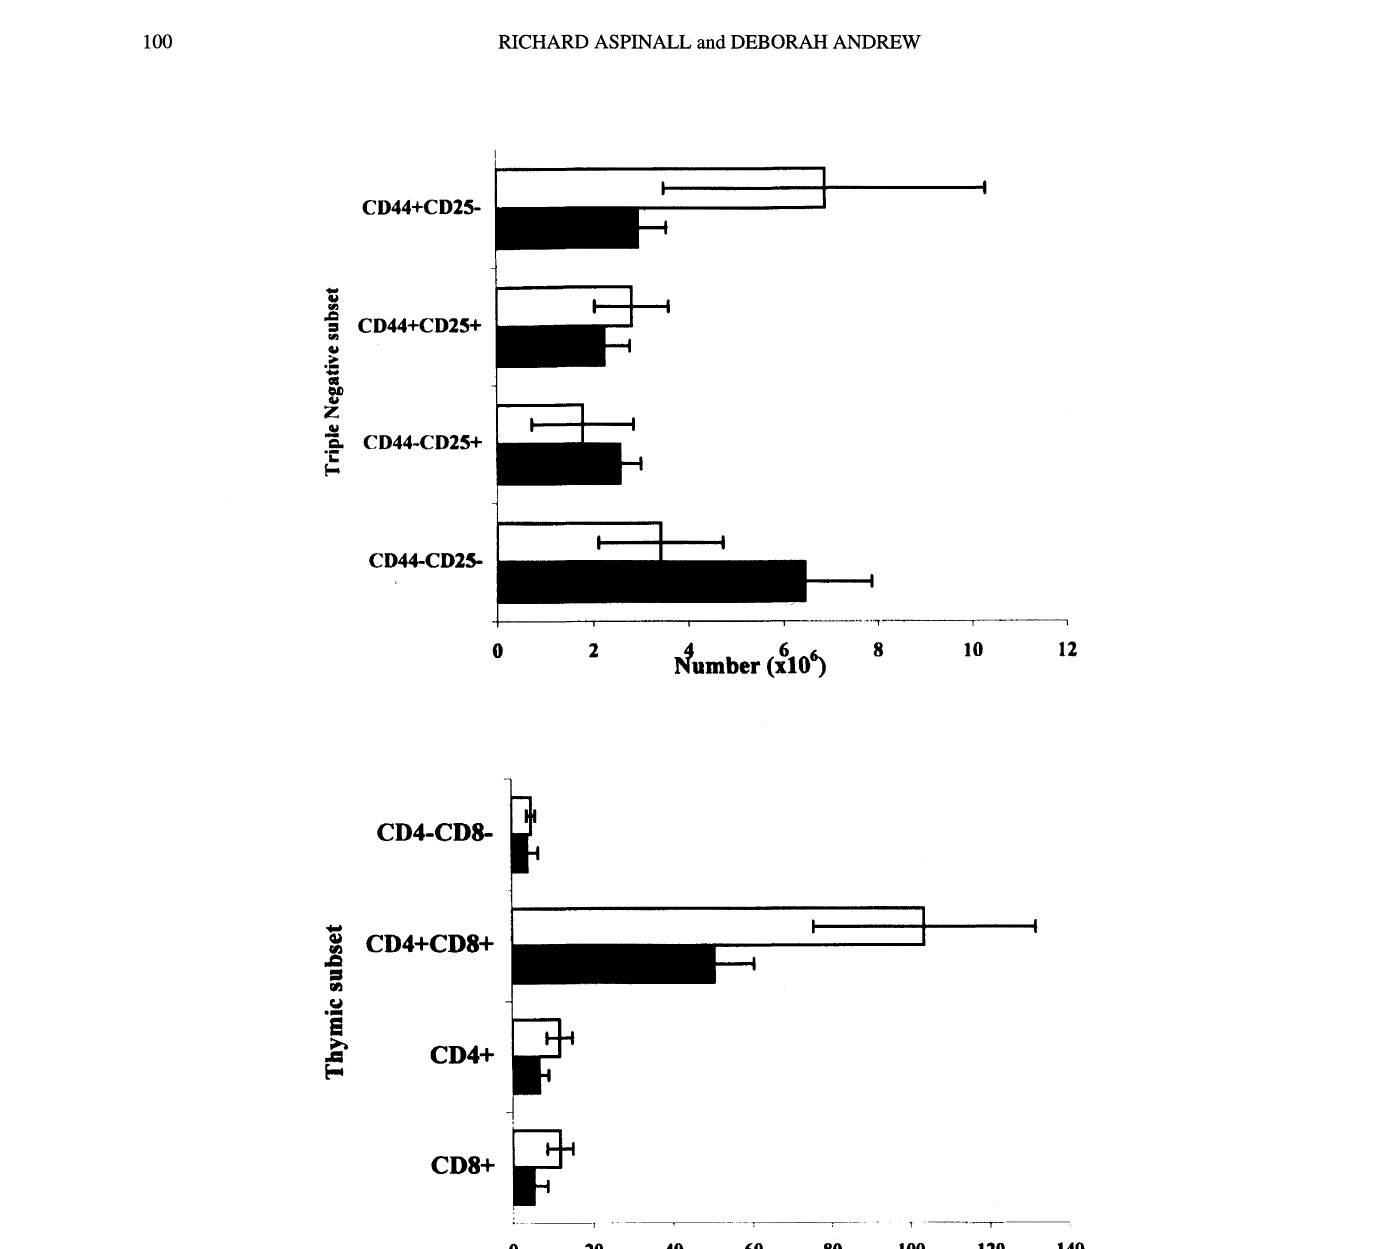
FIGURE 3 Analysis of thymocyte numbers at 9 months of age shows (i) similar numbers within all 4 TN populations defined by their expression of CD44 and CD25 and (ii) a significant increase (P<0.01) in the number of CD4/CD8 cells in female (unfilled bars) mice when compared to males (filled bars). Increased numbers of CD4 and CD8 cells were noted in the female thymus at this time point